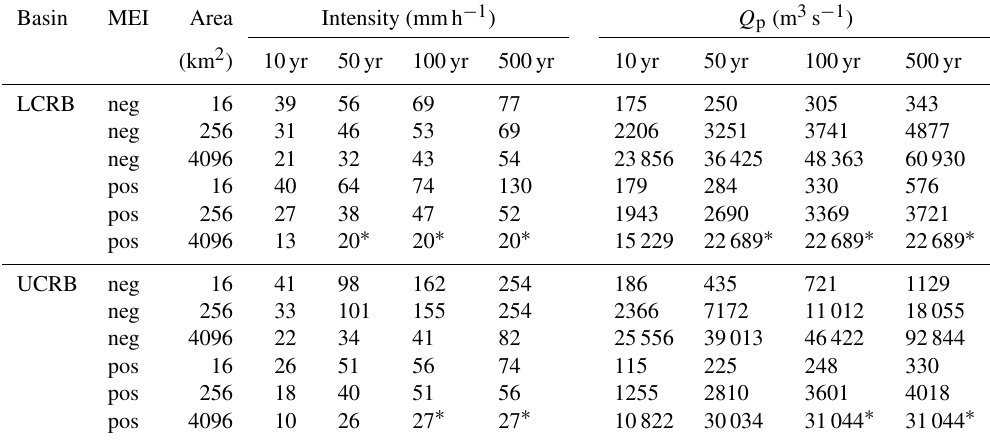
Table 3. Maximum rainfall intensity and Q p values for 10-, 50-, 100-, and 500-year recurrence intervals during negative (neg) and positive (pos) multivariate ENSO index (MEI) conditions within the Lower Colorado River Basin (LCRB) and Upper Colorado River Basin (UCRB). Note that data are all sampled from time intervals of measurement ≤ 2h.